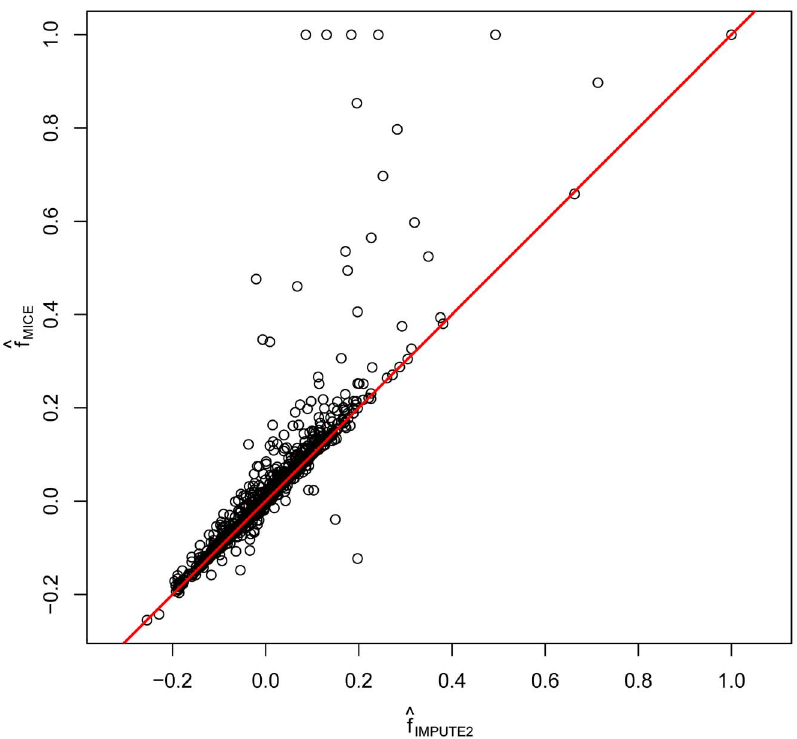
Figure 6. Scatter plot of inbreeding coefficients for 1070 non-monomorphic SNPs with missings obtained by multiple imputation (MICE) and single imputation (IMPUTE2).